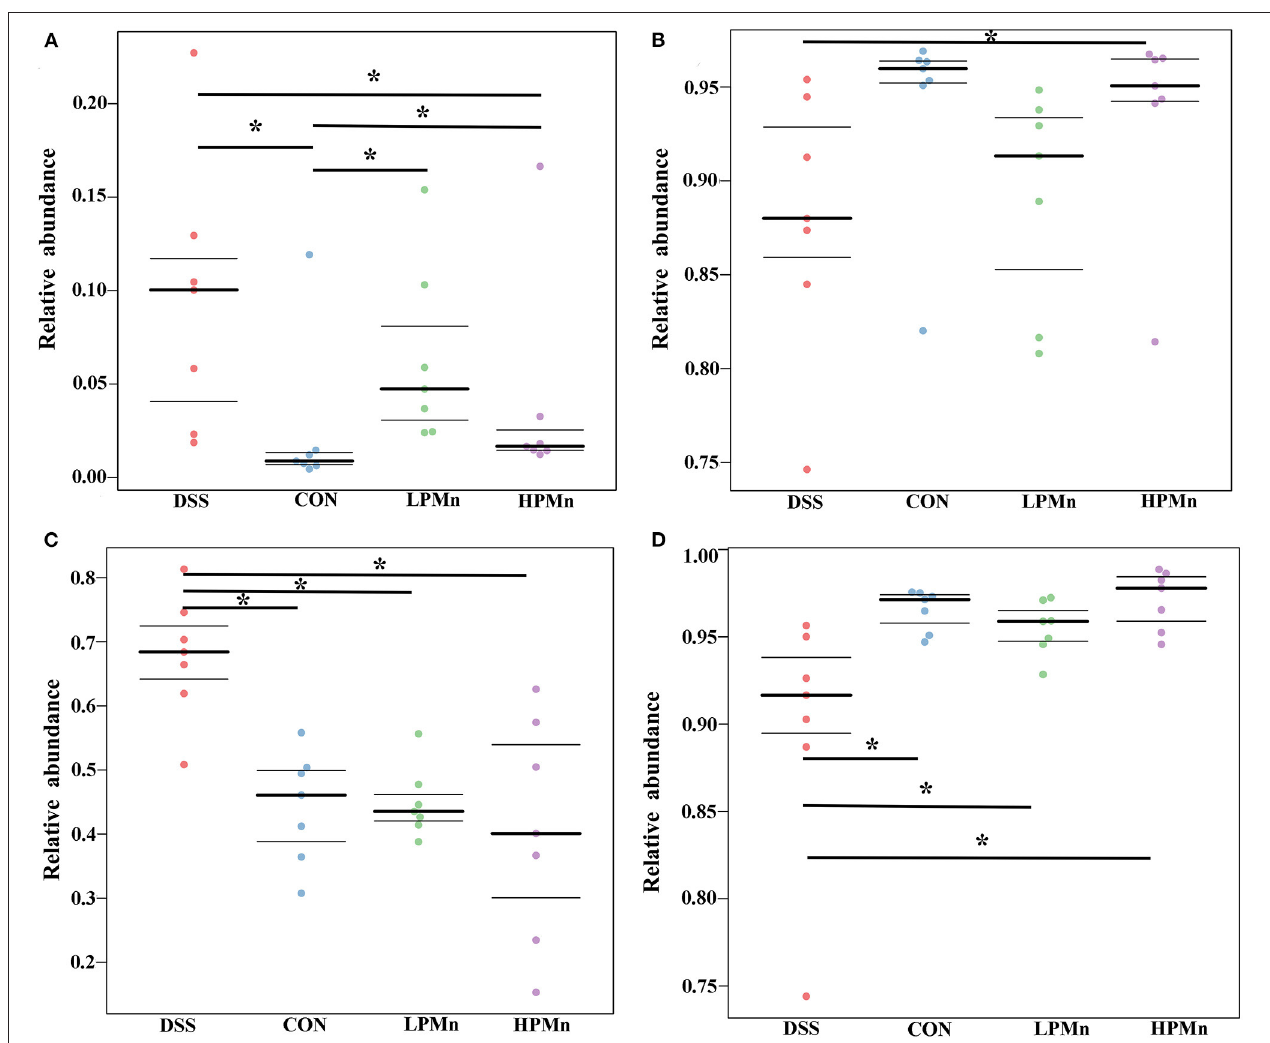
FIGURE 6 | Ulva polysaccharide-manganese altered microbiome phenotypes. Relative abundance of aerobic (A) and anaerobic microbes (B) , microbes contains mobile elements (C) , and stress tolerant-related microbes (D) . Values are expressed as mean ± SEM, n = 7. * P < 0.05.